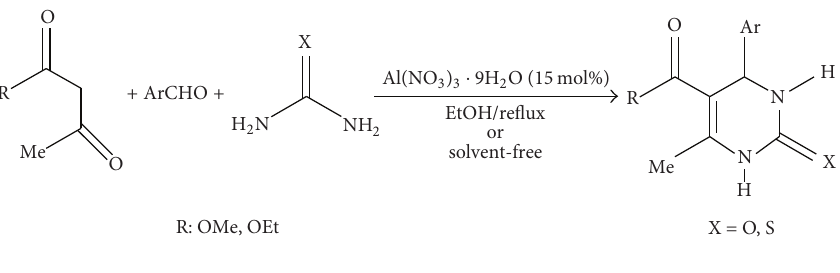
F 1: Aluminum nitrate-catalyzed synthesis of 3,4-dihydropyrimidin-2-ones/thiones.